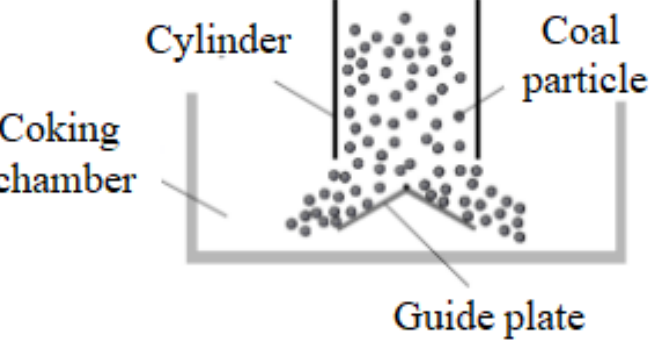
Figure 5. The movement of coal particles on the guide plate.